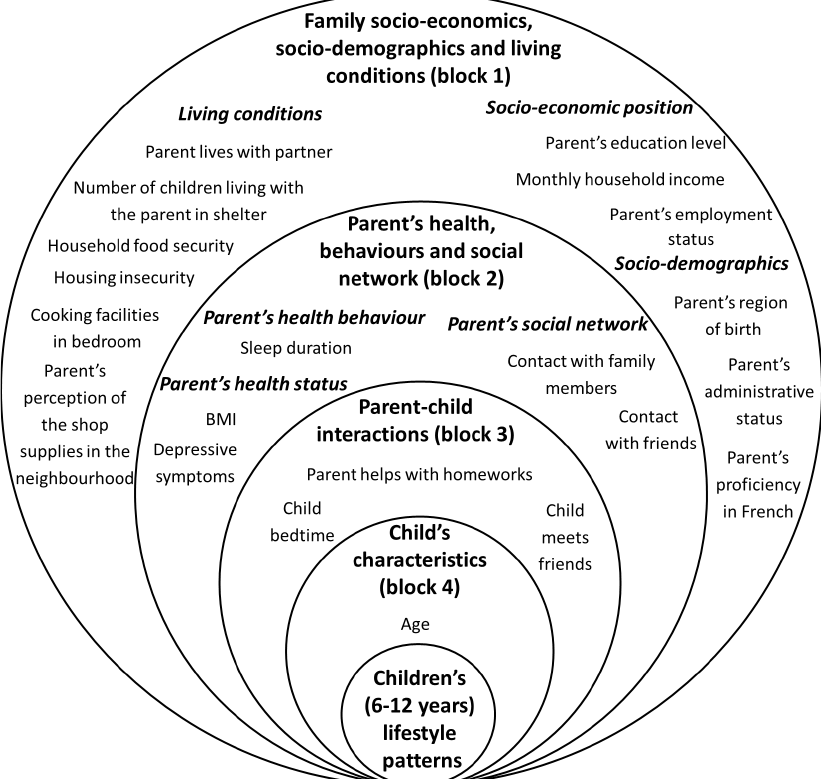
Figure 1. Socio-ecological model for correlates of lifestyle patterns among homeless children (6 – 12 years). Adapted from Descarpentrie et al., 2021, and Frenoy et al., 2021